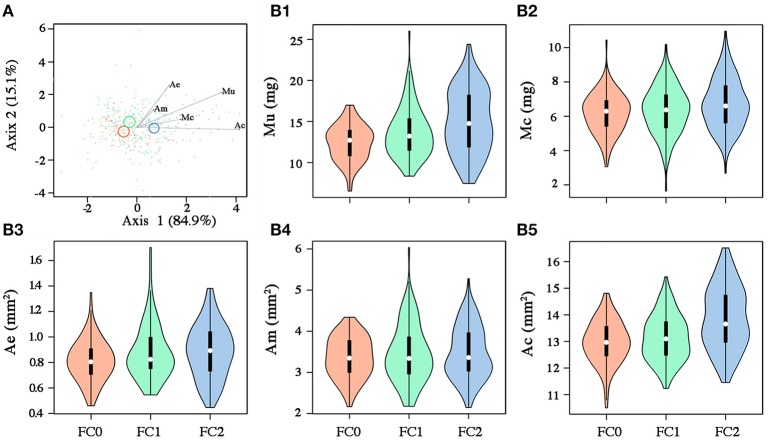
(A) Canonical variate analysis on seed morphometric traits (Mu, mass of the uncoated seed; Mc, mass of the coat; Ae, area of the embryo; Am, area of the megagametophyte; Ac, area of the coronal section of the seed). Fire cohorts are coded in different colors (FC0: red; FC1: green; FC2: blue). Vectors indicate the strength and influence of specific morphometric traits on point location relative to canonical axis 1 and axis 2. Confidence circles (for α = 0.05) are also shown, enclosing the true mean of each group at the 95% confidence level and highlighting significant differences among groups in case of no overlap. (B) Violin plots for seed morphometric traits: [Mu: B1; Mc: B2; Ae: B3; Am: B4; Ac: B5]. White circles, black rectangle and upper and lower lines for each violin represent the median, the interquartile range and the upper and lower whisker, respectively. Colored bands represent the kernel density plot.